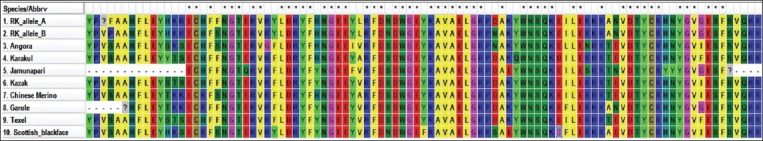
Amino acid alignment by Clustal W of the studied sequence (using MEGA 6.0). RK allele A: Rohilkhandi goat allele A (Acc. no. KP888556); RK allele B: Rohilkhandi goat allele B (Acc. no. KP888557).